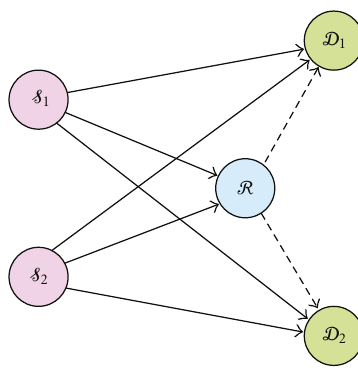
Figure 1: Multisource-multicast network model.